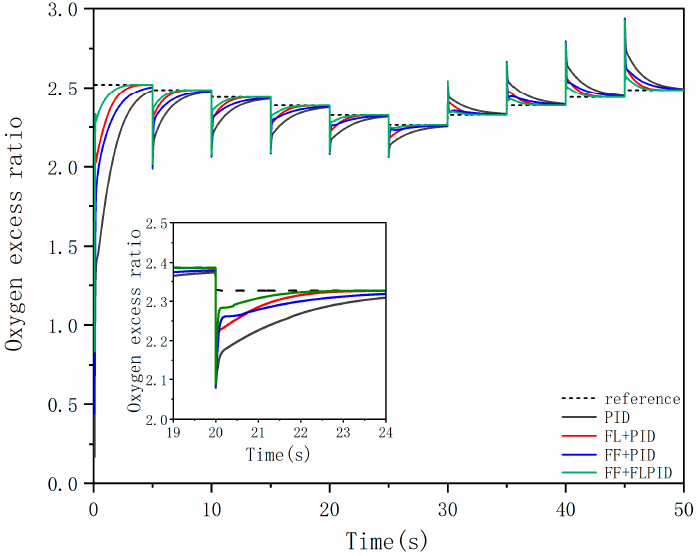
Figure 14. Response of variable oxygen excess ratio for different control strategies. Table 2. Control effects of different control strategies at 10 s.